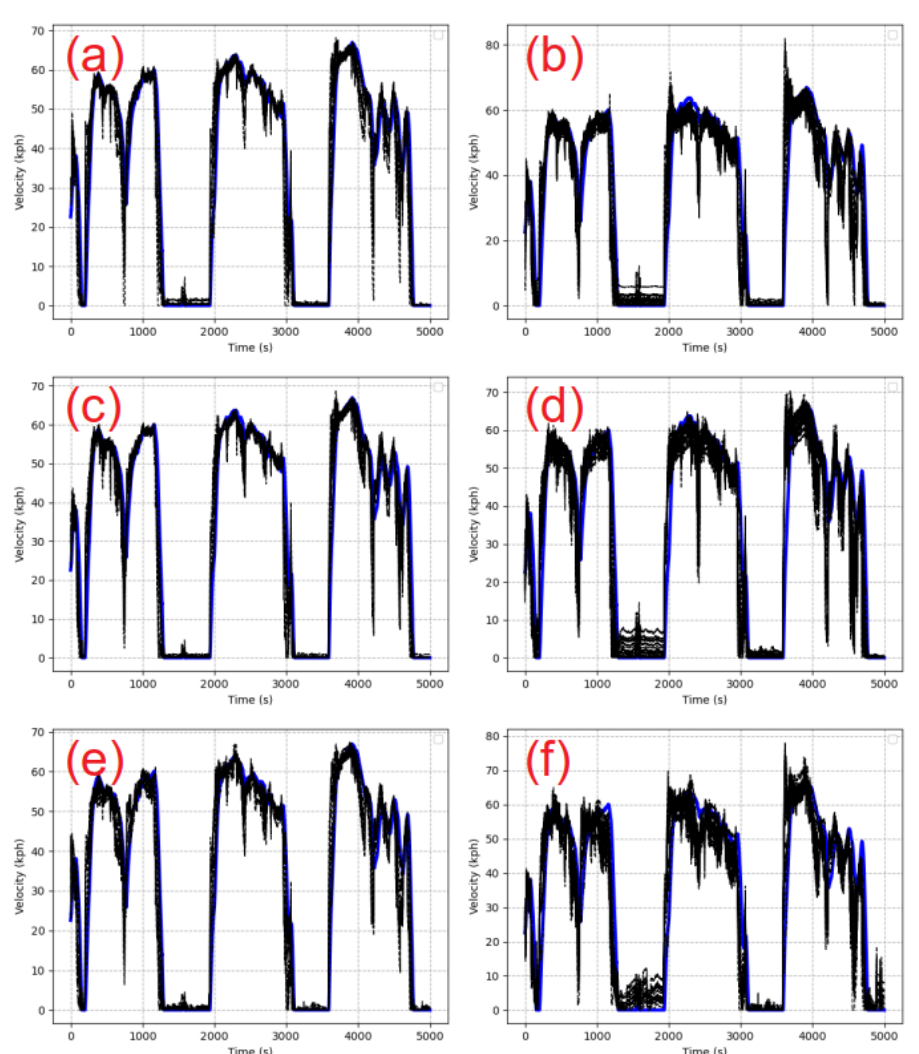
Figure 8. Predicted (black) vs. actual vehicle velocity (blue) for LSTM DNN trained on all data groups at 10 and 20 s prediction horizon. ( a ) is group A at 10 s, ( b ) is group A at 20 s, ( c ) is group B at 10 s, ( d ) is group B at 20 s, ( e ) is group C at 10 s, ( f ) is group C at 20